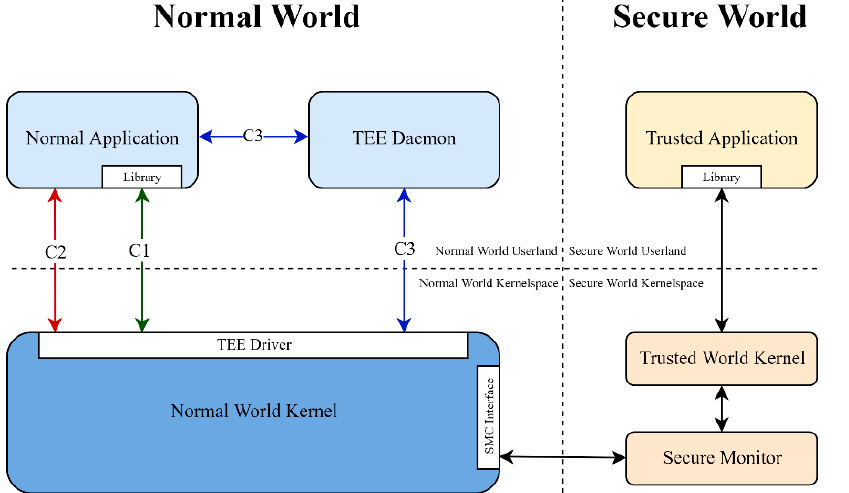
Figure 2. Communication Channels Between the Normal and the Secure world.